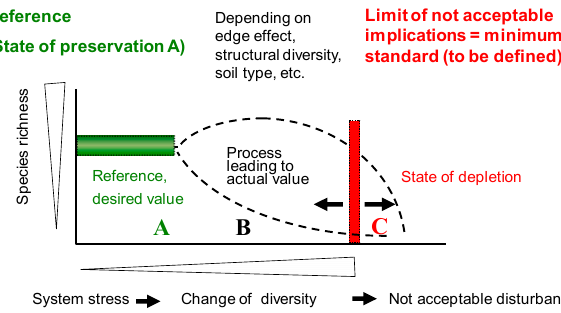
Figure 1. Derivation of references values in relation to a desired range (e.g., in terms of species number, community composition etc.): A, B and C represent different preservation states depending on the level of stress (e.g., soil contamination), reproduced with permission from [32]. Copyright Soil Organism, 2013.